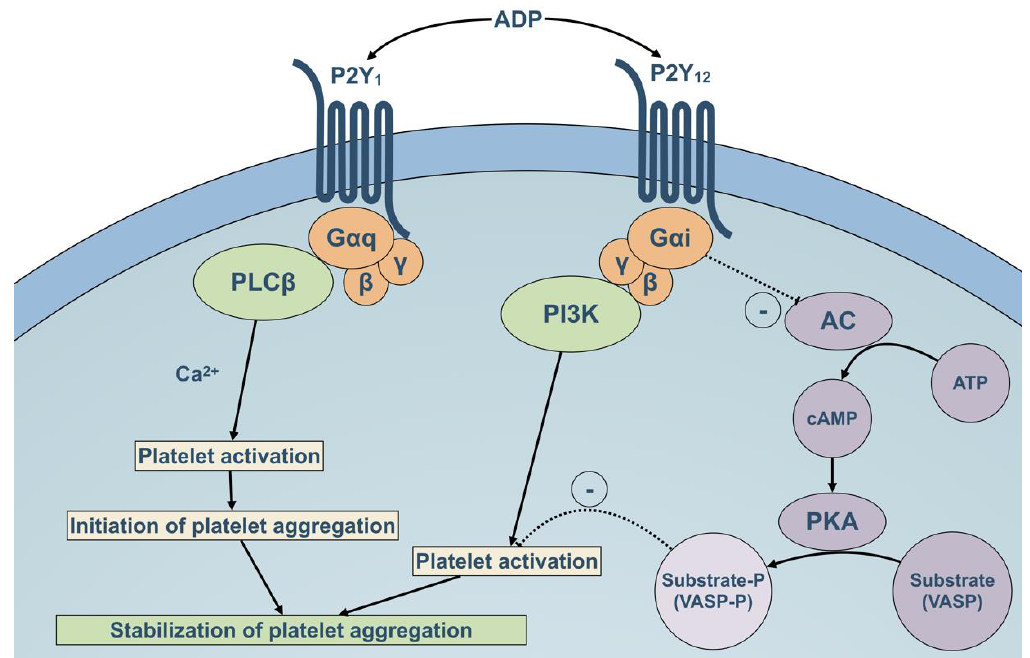
Figure 1. Schematic illustration of the platelet P2-mediated ADP signaling pathway and its role in platelet activation. ADP can induce platelet activation by interacting with two G-coupled platelet receptors, P2Y 1 and P2Y 12 , and contributes to the stabilization of platelet aggregation induced by other strong agonists such as thrombin and TXA2. ADP binding to P2Y 1 induces a mobilization of calcium ions through the stimulation of phospholipase C and therefore initiates early reversible aggregation. ADP binding to P2Y 12 induces PI3K activation through the recruitment of βγ subunits of Gi and inhibition of adenylate cyclase through the recruitment of αi subunit, therefore decreasing cAMP levels and leading to impaired PKA activation. These pathways ultimately lead to platelet activation, αIIbβ3 activation and stabilization of platelet aggregates. AC: adenylate cyclase; ADP: adenosine diphosphate; ATP: adenosine triphosphate; PI3K: phosphoinositide-3-kinase; PKA: